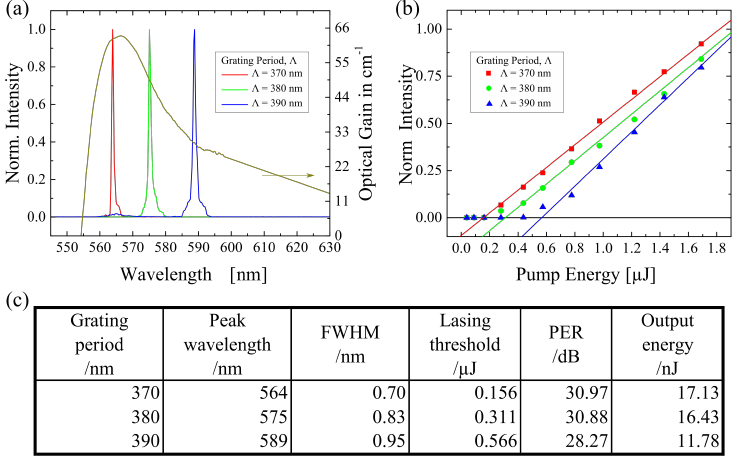
Figure 4. When the grating period (370 nm, 380 nm, and 390 nm) was altered, ( a ) the lasing spectra and ( b ) the lasing threshold were defined. While, the summary of the result of lasing properties was presented in ( c